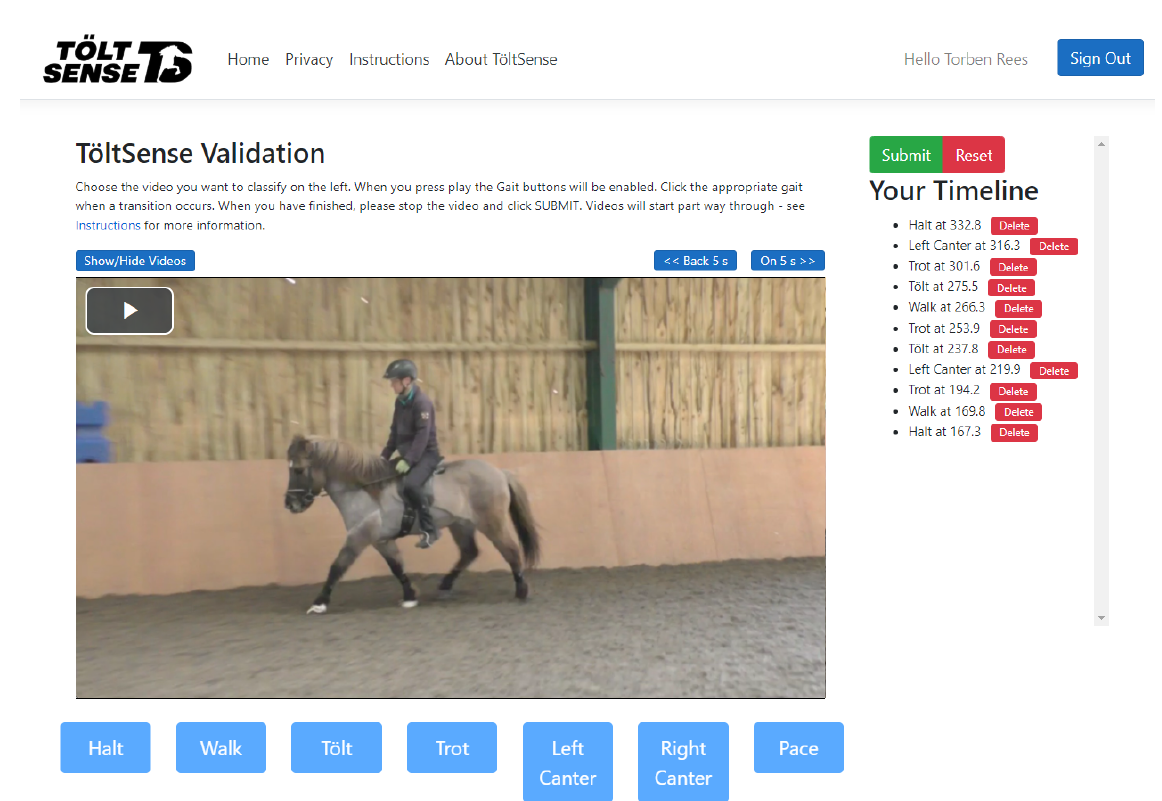
Figure 3. The web application used by the judges to assign gait labels to video